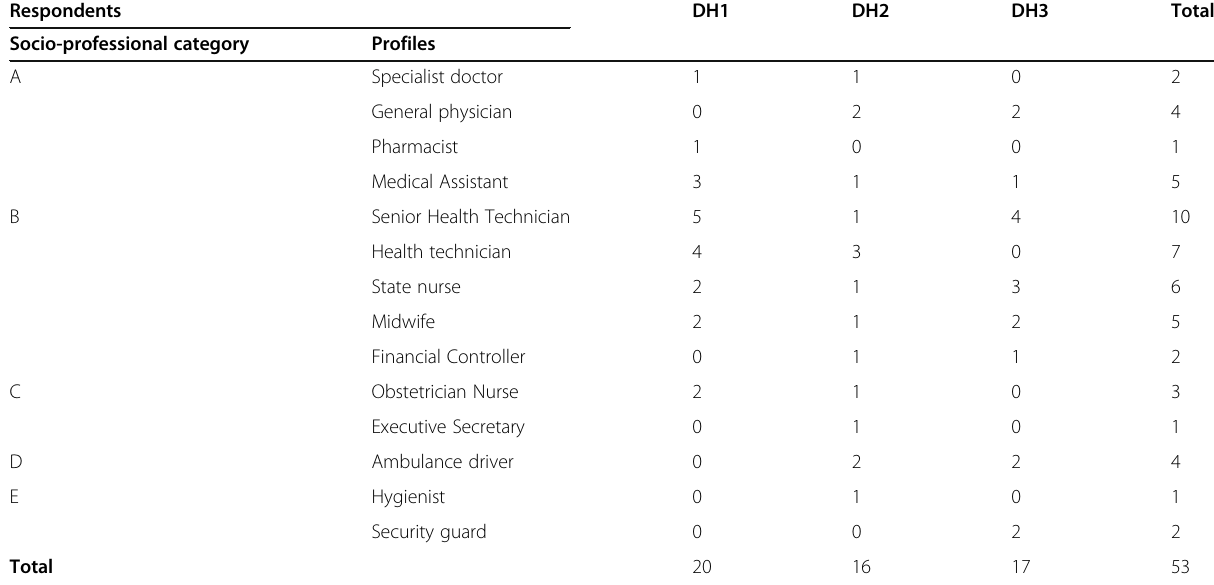
Table 1 Respondents in the study